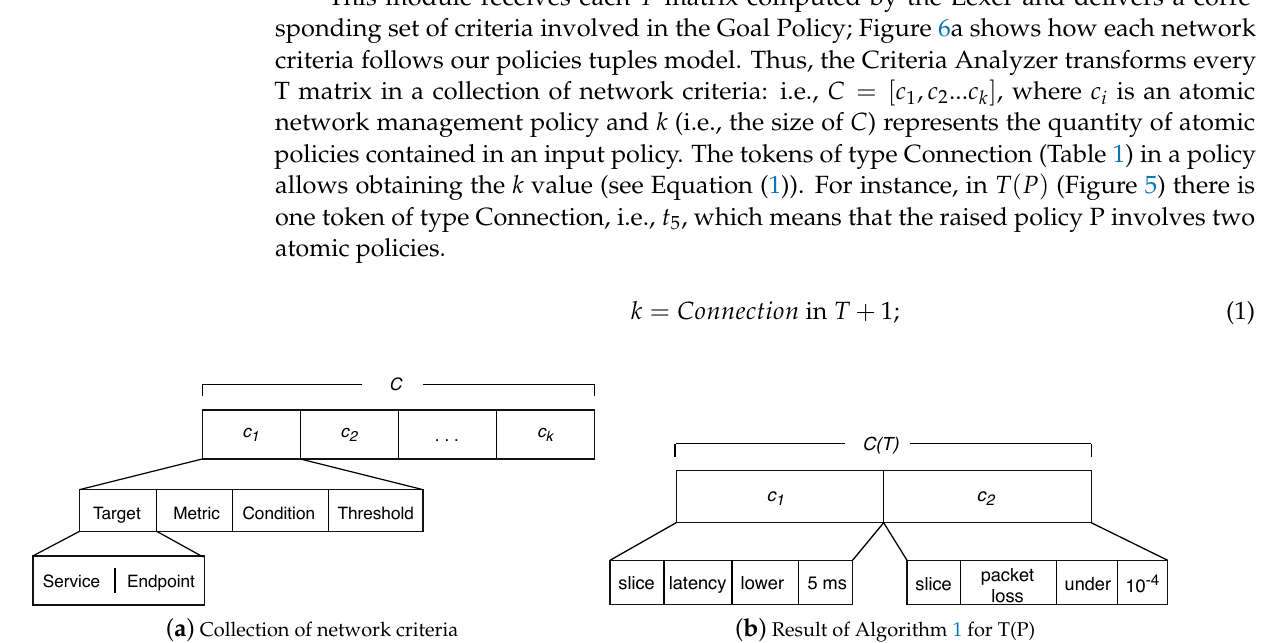
( b ) Result of Algorithm 1 for T(P) Figure 6. Criteria vs. Goal Policy